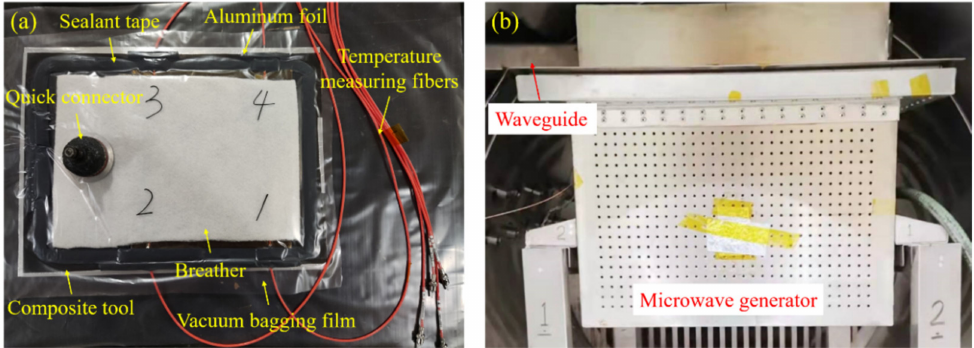
Figure 14. ( a ) Arrangement of the temperature measuring fibers; ( b ) traditional microwave heat- ing